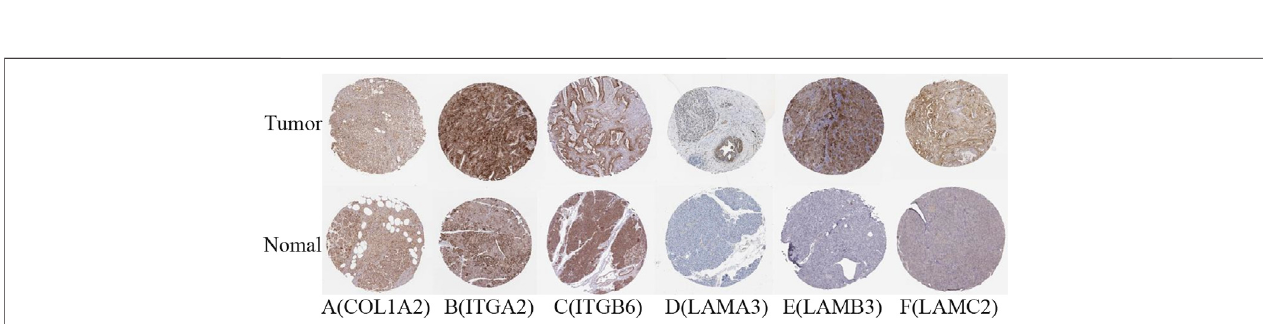
FIGURE 6 | Veri fi cation of hub DEG expression in PAAD and normal tissue using the HPA database. (A) COL1A2, (B) ITGA2, (C) ITGB6, (D) LAMA3, (E) LAMB3, and (F) LAMC2.